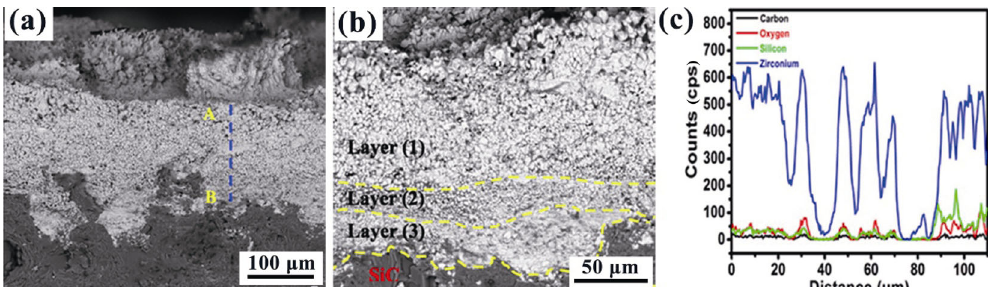
Fig. 36 Cross-section micrograph and element line analysis of the ZrB 2 –SiC–ZrC coating after ablation. Reproduced with permission from Ref. [293], © Elsevier B.V. 2016.